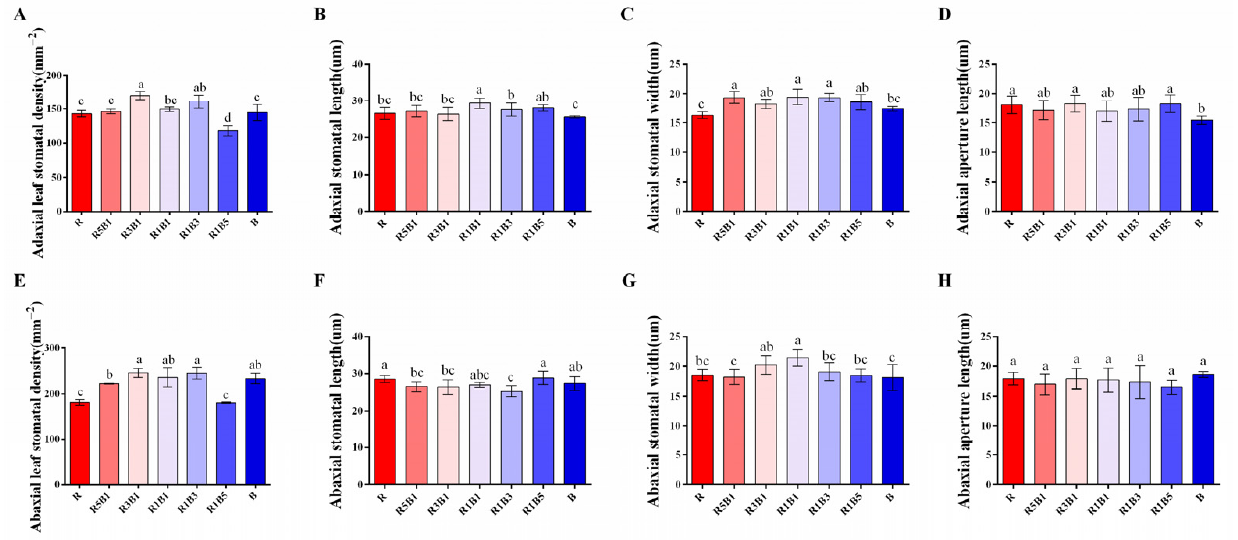
Figure 8. Effects of various ratios of R and B light on stomatal density ( A , E ), length ( B , F ), and width ( C , G ), as well as aperture length ( D , H ) on the adaxial and abaxial sides of leaves. Bars represent the mean ± SD ( n = 9). According to one way ANOVA, different letters denote statistically significant differences between treatments (Duncan’s test, p < 0.05). R: monochromatic red light; R1B5: red to blue ratio = 1:5; R1B3: red to blue ratio = 1:3; R1B1: red to blue ratio = 1:1; R1B3: red to blue ratio = 1:3; R1B5: red to blue ratio = 1:5; B: monochromatic blue light.